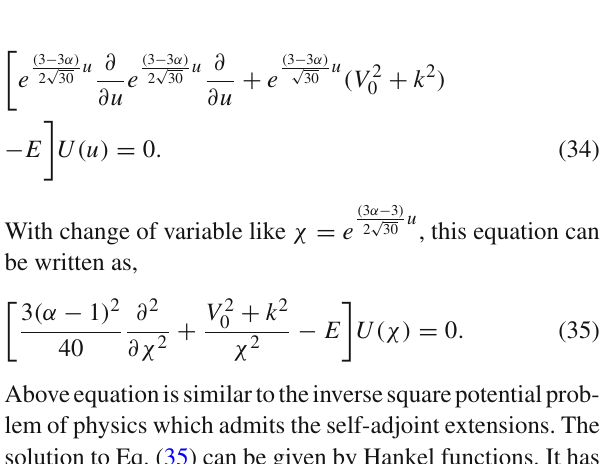
Fig. 1 Expectation value of scale factors for n = 6 Fig. 2 Expectation value of scale factors for n = 8